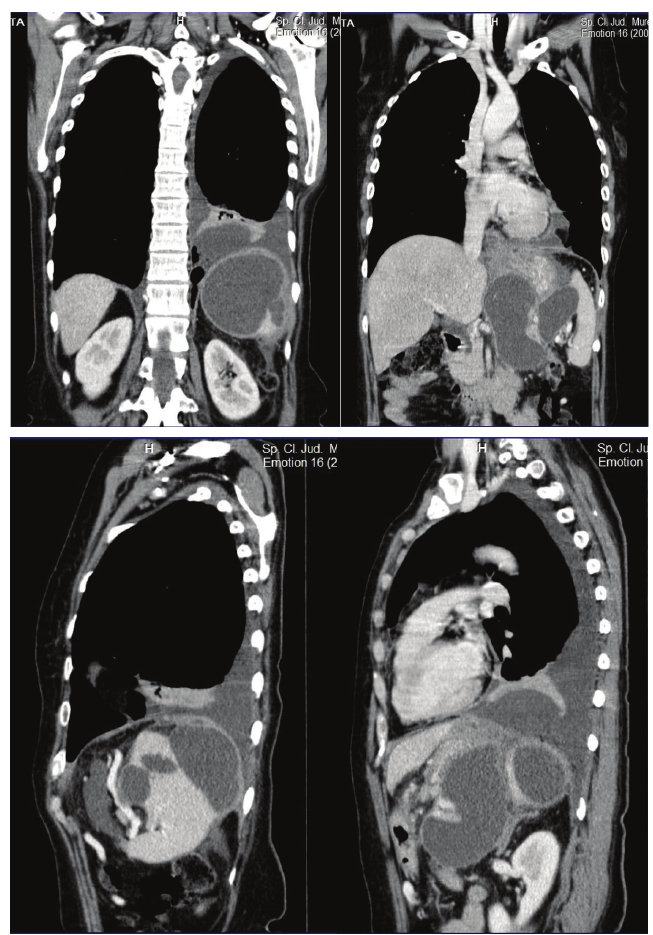
Figure 2: Preoperative CT scan: 3D